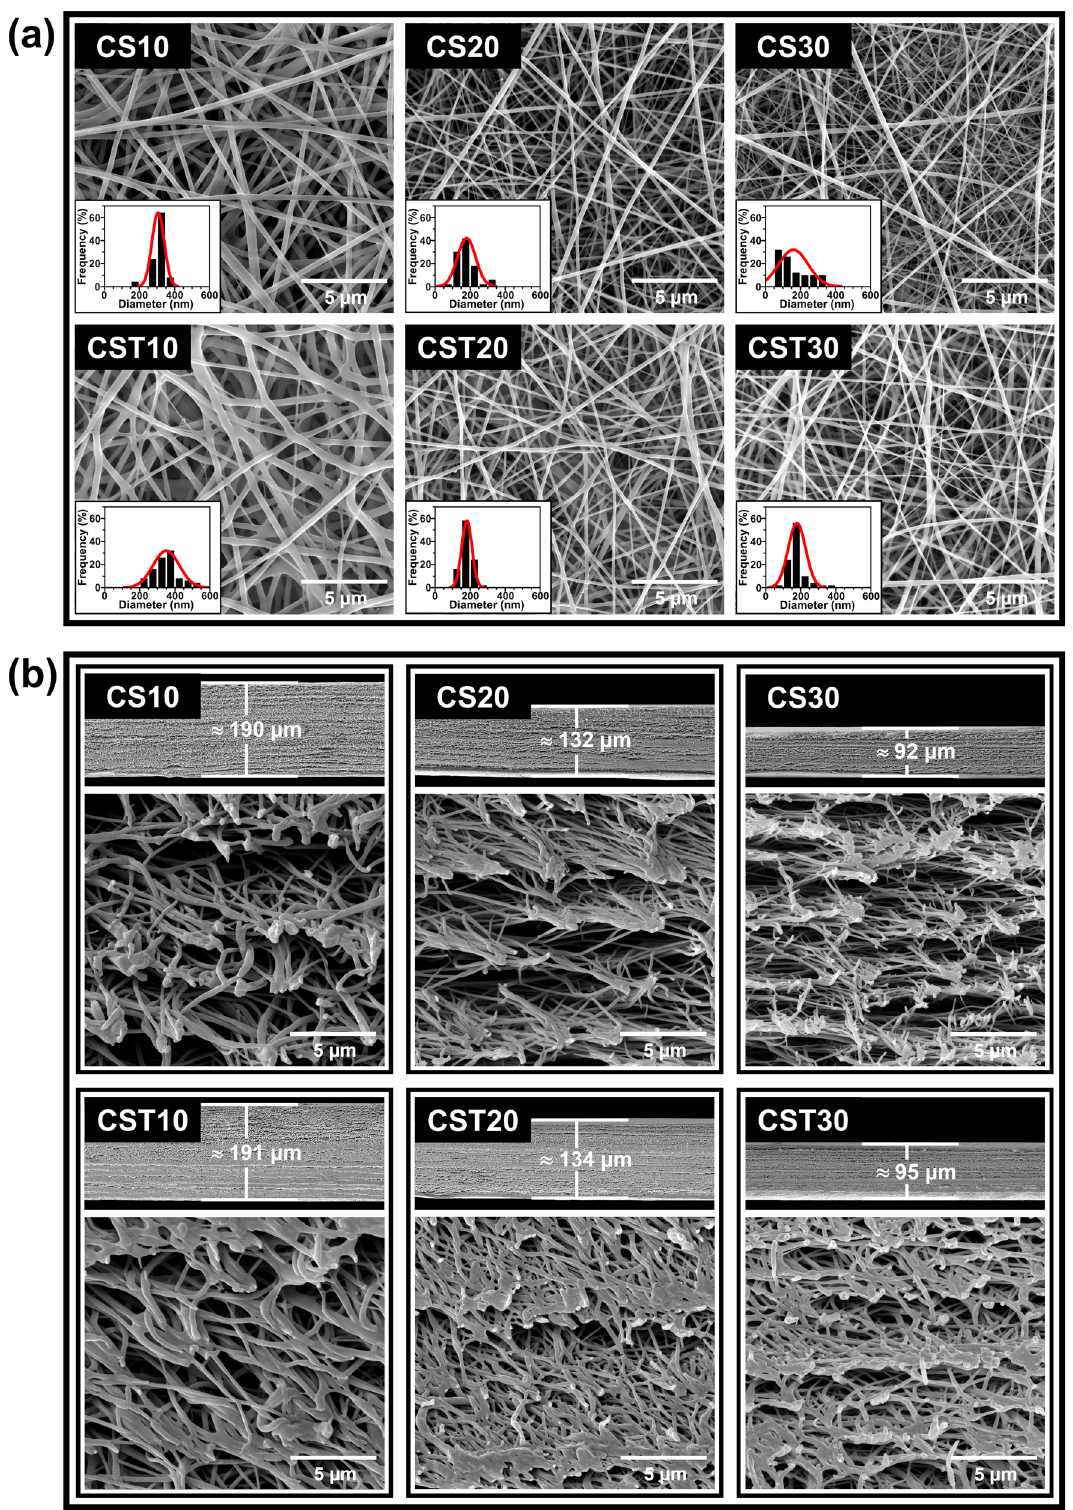
Figure 4: FESEM images of: ( a ) surface morphology and ( b ) thickness ( top ) and cross - sectional morphology ( bottom ) of the nano fi ber mats with and without T80